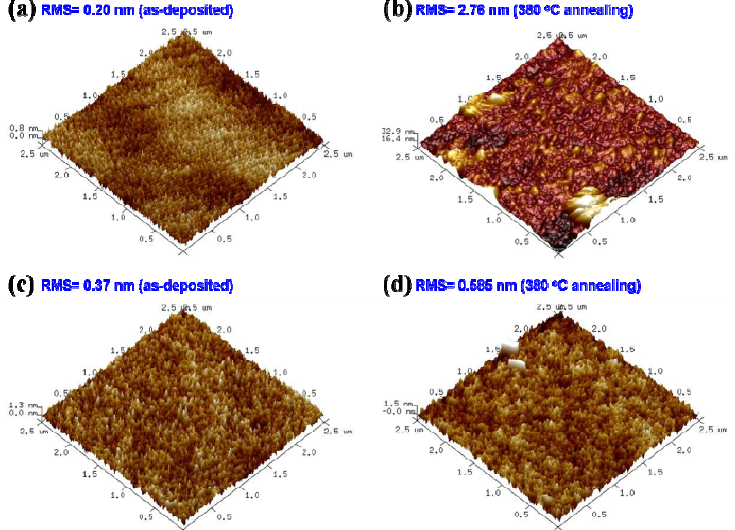
Figure 4. 3D AFM images with a scan area of 2.5 μ m × 2.5 μ m: ( a ) as-deposited; ( b ) 380 °C annealing SnO 2 − x thin films at the flow ratio of 0.5 of O 2 /(O 2 + Ar) and a working pressure of 4 × 10 − 2 Pa. ( c ) As-deposited; ( d ) 380 °C annealing SnO 2 − x thin films at the flow ratio of 0.5 of O 2 /(O 2 + Ar) and a working pressure of 4.7 × 10 − 2 Pa.